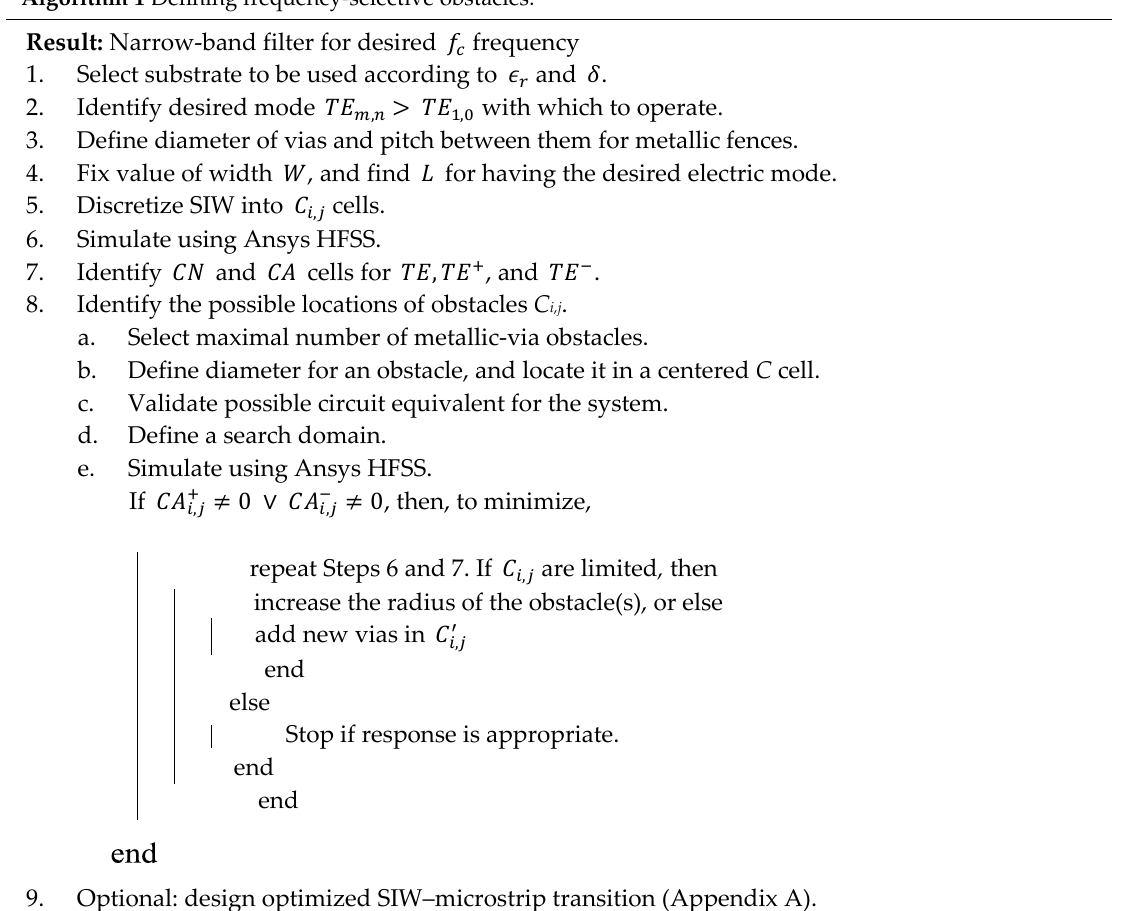
Figure 3. Obstacle location inside SIW. ( a ) SIW discretized into C i,j square cells; ( b ) division of cells inside SIW. Algorithm 1 Defining frequency-selective obstacles. Algorithm 1 Defining frequency-selective obstacles